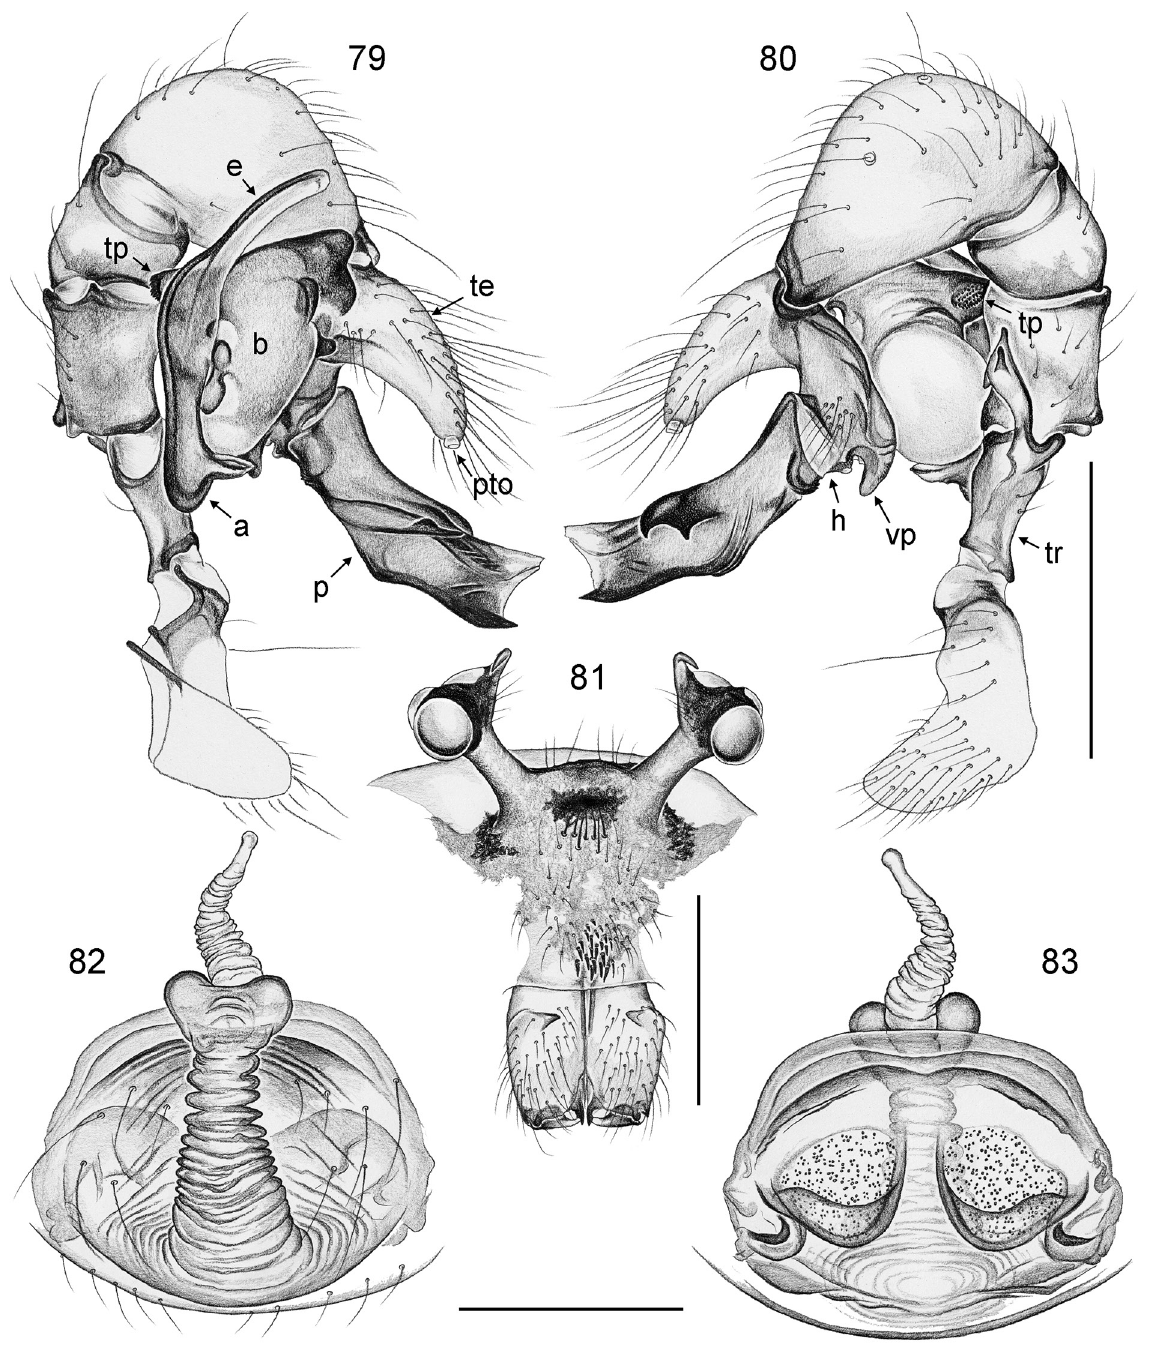
Figs 79–83. Panjange marilog Huber sp. nov. (ZFMK, Ar 13019) 79–80 . Left male palp, prolateral and retrolateral views. 81 . Male prosoma and chelicerae, frontal view. 82–83 . Cleared female genitalia, ventral and dorsal views. Abbreviations: a = appendix; b = genital bulb; e = embolus; h = hinge; p = procursus; pto = palpal tarsal organ; te = tarsal elongation; tp = toothed process of proximal bulbal sclerite; tr = trochanter; vp = ventral process. Scale bars: 79–81 = 0.5 mm; 82–83 = 0.3